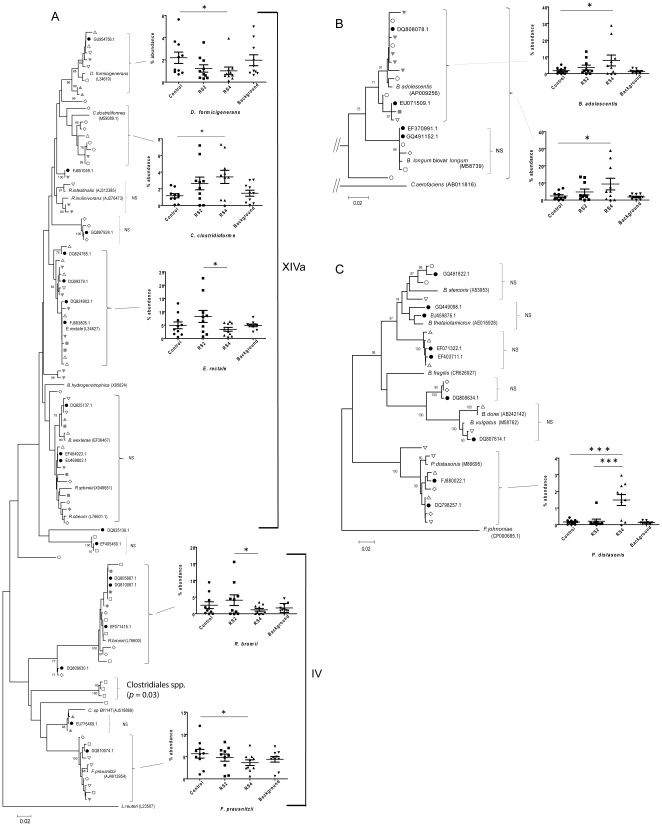
Characterization of the fecal microbiota in ten human subjects that consumed a random succession of crackers containing RS2, RS4, and native wheat starch (control) by multiplex pyrosequencing of 16S rRNA tags.Phylogenetic trees that encompass the phyla (A) Firmicutes (with Clostridiales groups XIVa and IV labeled), (B) Actinobacteria and (C) Bacteroidetes are shown. The trees contain representative sequences of all OTUs detected to be impacted by RS in individual subjects together with sequences of related entries in the database (which included both type strains of known species and sequences from molecular studies of human fecal samples). Sequences were aligned in Muscle 3.6 and the trees were built using the neighbor-joining algorithm with 1,000 bootstrap replicates in MEGA 4.0. Open-black and closed-gray symbols were used to label sequences from individual subjects. OTUs that were not significantly affected in all ten subjects were labeled as ‘not significant’ (NS). The graphs next to the trees show the abundance of OTUs and bacterial groups that were significantly altered in the treatment groups (RS2, RS4, control). These graphs show mean proportions of the three individual samples taken during the treatment periods for each subject. Background refers to samples taken in periods were no crackers were consumed. Repeated measures ANOVA in combination with a Tukey's post-hoc test were performed to indentify differences between treatment groups, and the background was not included in the statistic analysis. *p<0.05; **p<0.01; ***p<0.001.